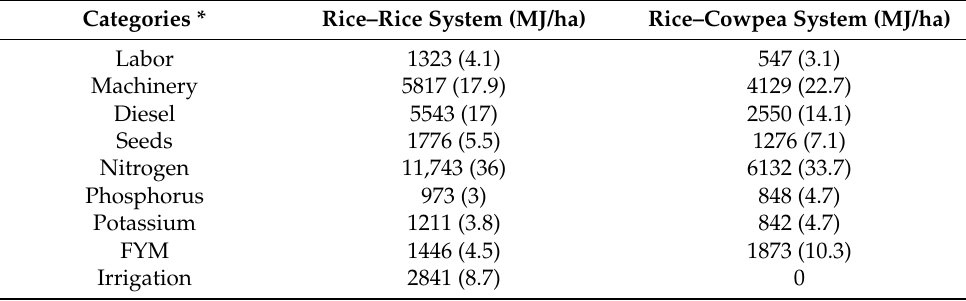
Table 2. Energy analysis of rice-based cropping systems in the coastal region of Goa.